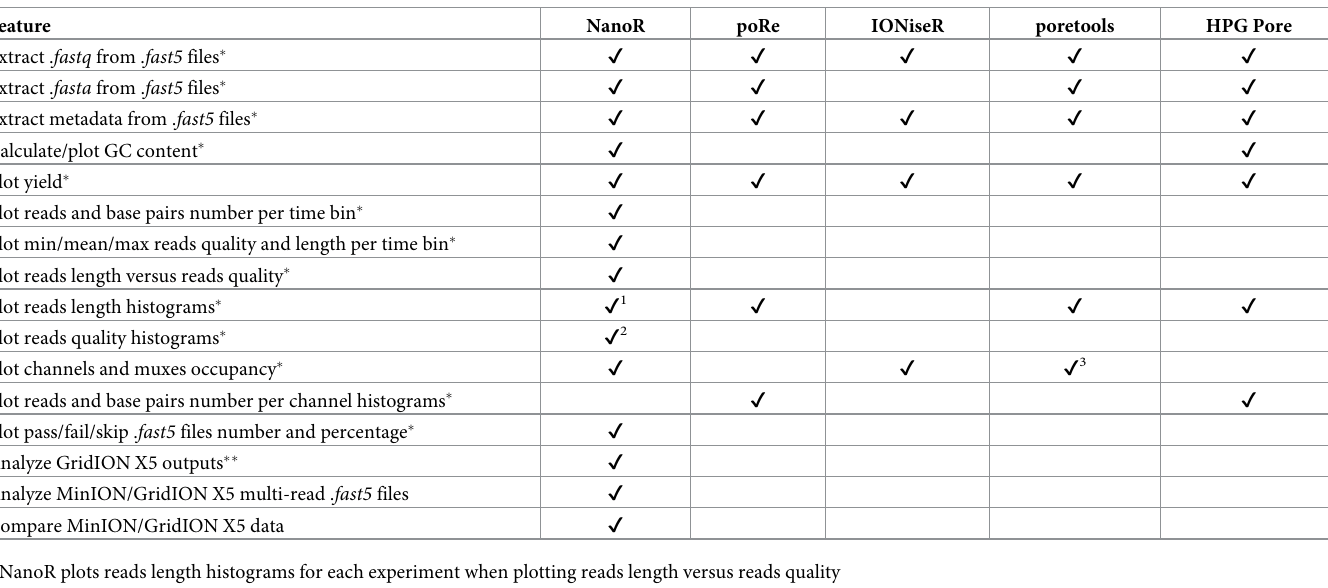
Table 1. Comparison between NanoR, poRe, IONiseR, poretools and HPG